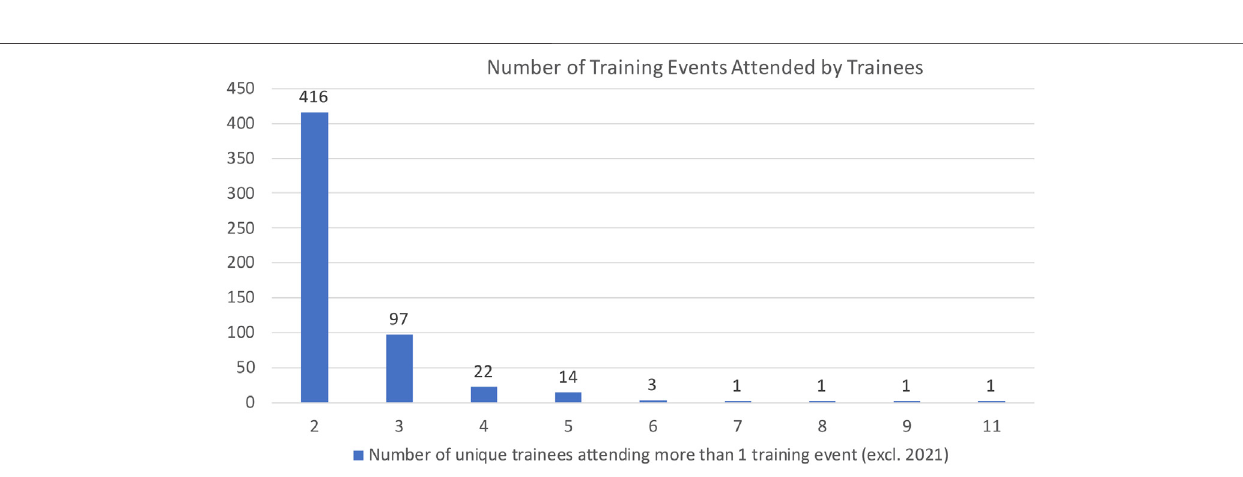
FIGURE 6 | Number of H3ABioNet training events attended by trainees. Most trainees attended just 1 training event (most often IBT, 3777 individuals), however, several went on to attend additional H3ABioNet training